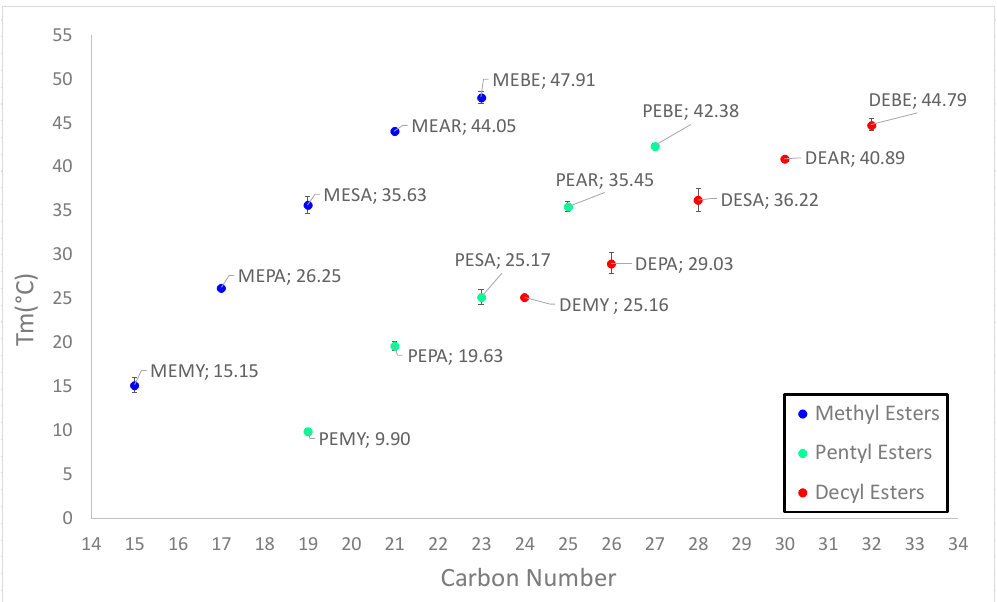
Figure 5. Scatter plot of the onset melting points of all esters reported in Table 4 for visual evaluation of the odd-even effect and the influence of the carboxylic acid chain length and the alcohol chain length on the phase change temperatures.